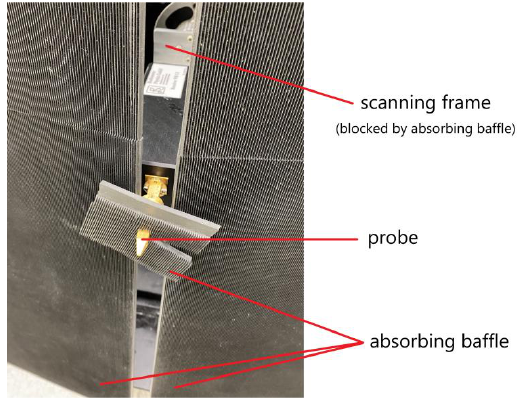
Figure 8. Scanning devices